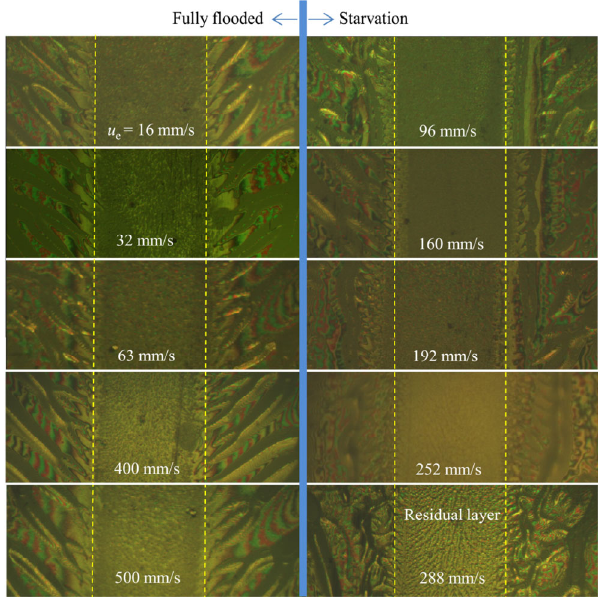
Fig. 11 Static rolling track after running, Grease A.